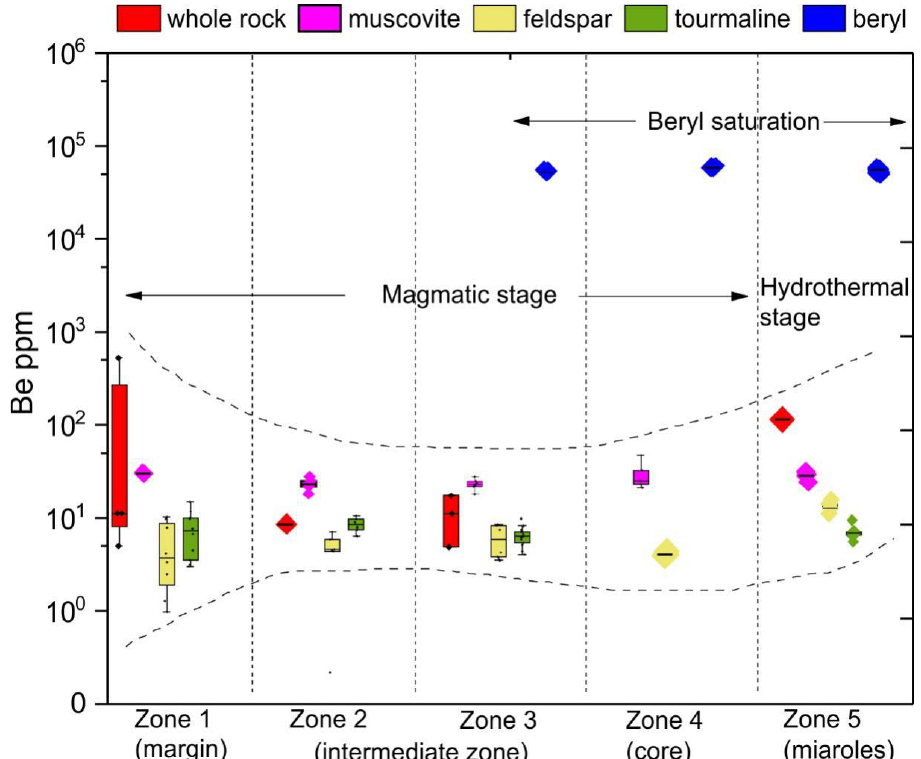
Figure 14. Box and whisker plot of Be-concentration in minerals and whole rock samples from five zones of Yamrang Pegmatite. Zone 1 – 4 represents the magmatic stage, and zone 5 represents the hydrothermal stage. Beryl saturation occurred at the late magmatic to the hydrothermal stage. Be content of beryl and tourmaline are taken from unpublished data of this author.